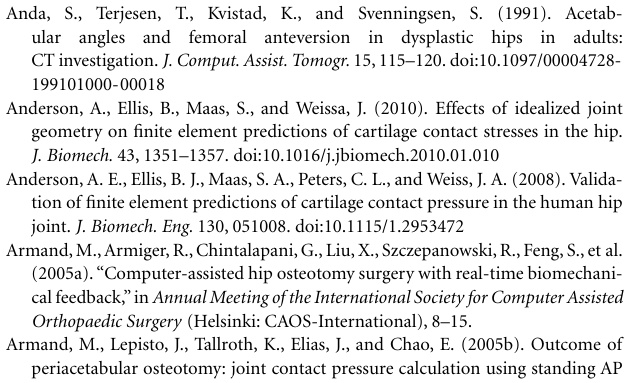
and the optimal alignments found using uniform, p-b dysplastic, p-b normal, and CT-based cartilage thickness models, respectively.The black line marks the border between normal and dysplastic values for the AC angle. Optimal orientation of the acetabulum results in improvement (decrease) of AC